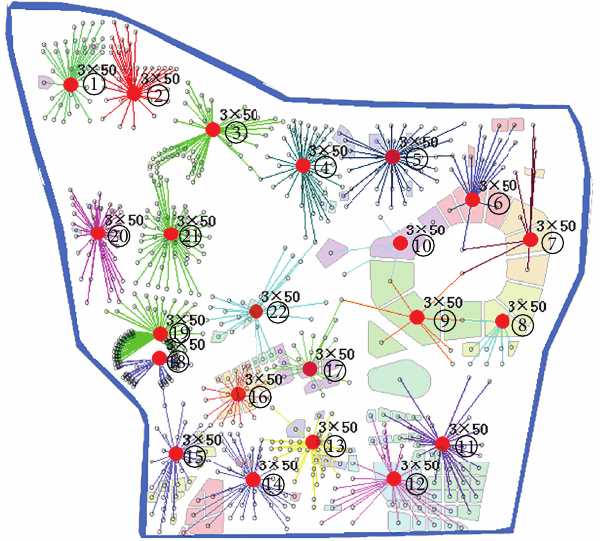
Figure 7: Planning result by adding the areas that cannot build